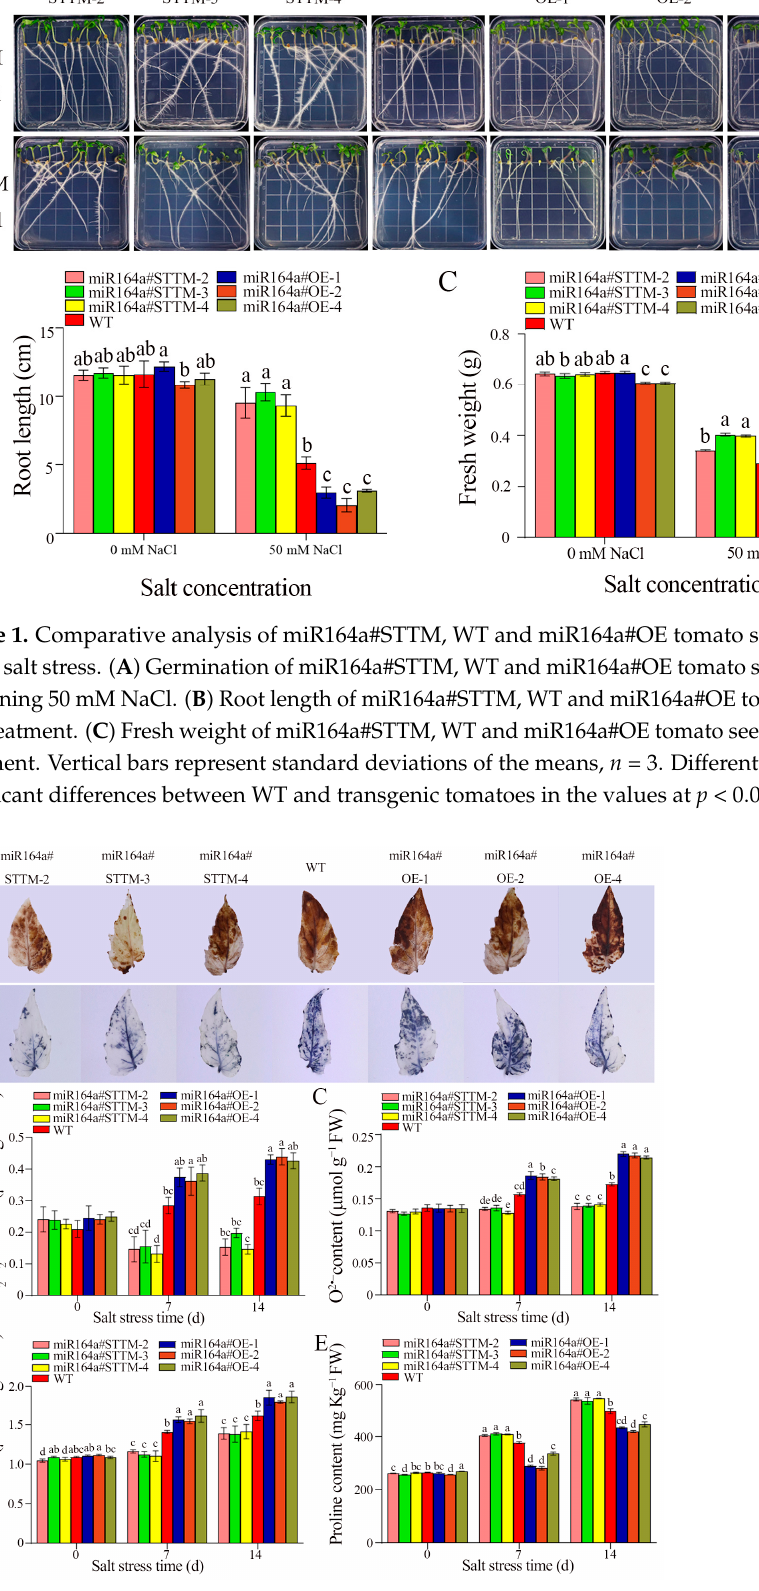
Figure 2. Analysis of ROS accumulation in miR164a#STTM, WT and miR164a#OE tomato seedlings under salt stress. ( A ) Comparison of DAB staining and NBT staining of miR164a#STTM, WT and miR164a # OE tomato leaf after 14 days of salt treatment. The H 2 O 2 content ( B ), O 2•– content ( C ), MDA content ( D ) and proline content ( E ) in tomato seedling root. Vertical bars represent standard devia- tions of the means, n = 3. Different letters indicated significant differences between WT and trans- genic tomatoes in the values at p < 0.05.